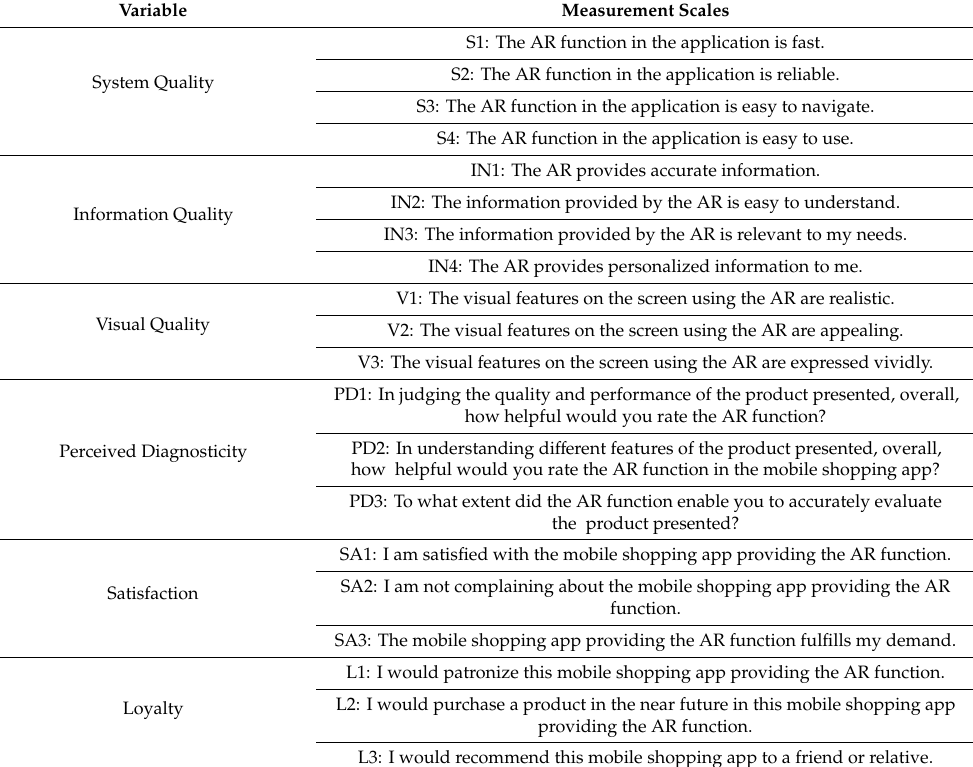
Table 1. Variables and